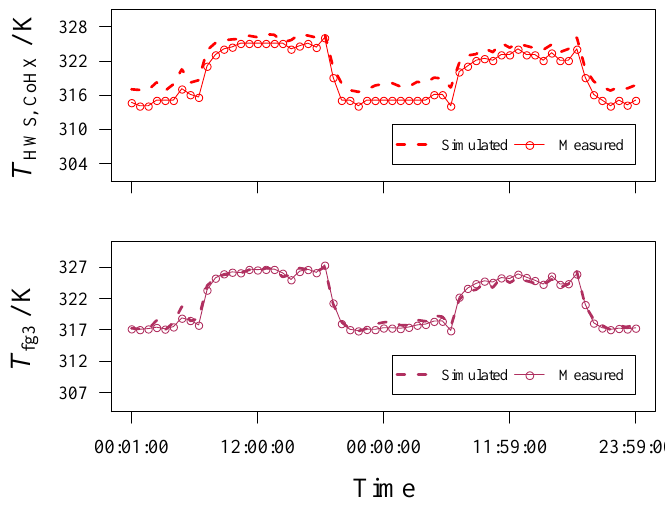
Figure 11. ( Top ) Hot water supply temperature of the CoHX vs. time; ( Bottom ) Flue gas temperature at the outlet of the CoHX vs. time. The simulated data was obtained by means of the input signals specified in Figure 8. The maximum absolute discrepancy for T HWS,CoHX and T fg3 was about 3.4K and